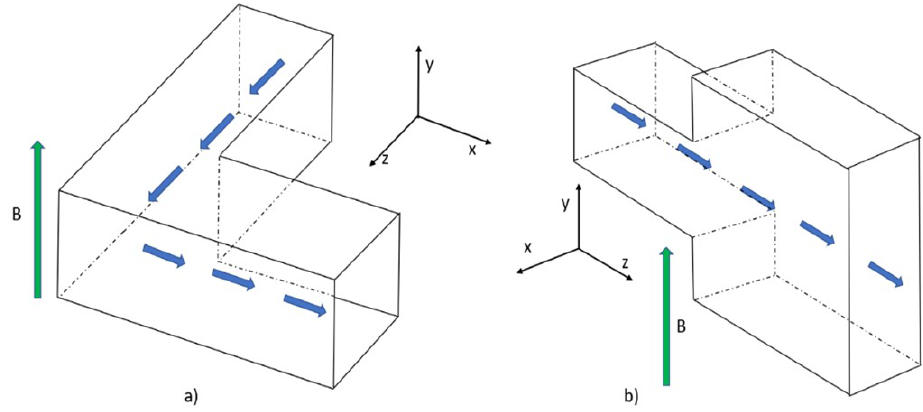
Figure 2. Geometry configurations examples that can be modelled with the new features imple- mented in the code. With the green vector is pointed the external magnetic field, B . ( a ) Bending square pipe geometry, with bending plane perpendicular to the magnetic field direction. ( b ) Square- to-rectangular duct expansion along B